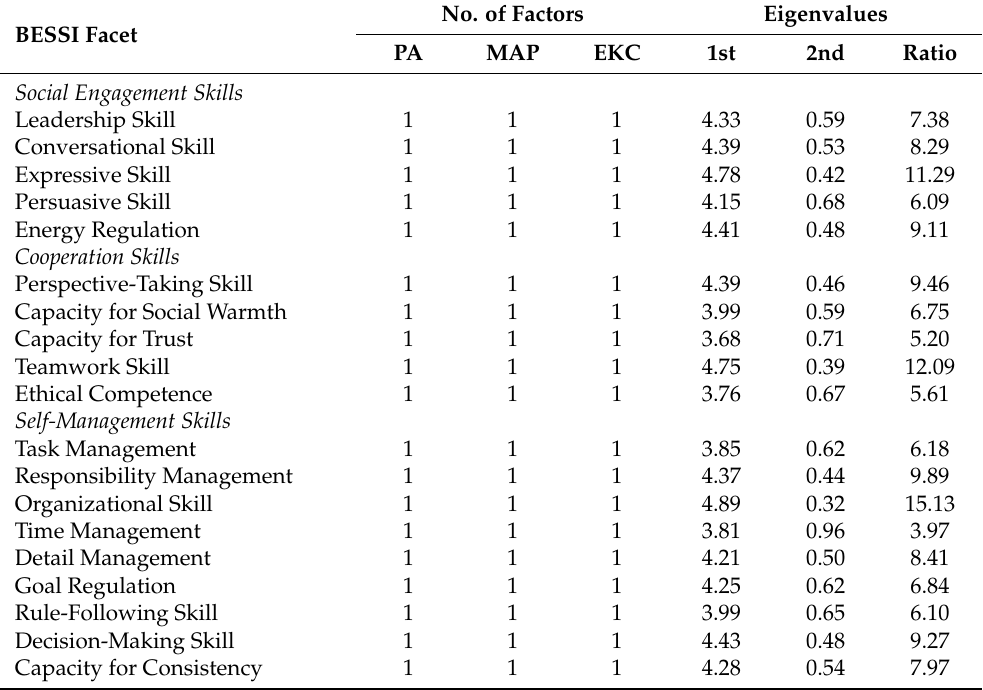
Table 1. Dimensionality of the 32 facets of BESSI-G v0.2 (Study 2). BESSI